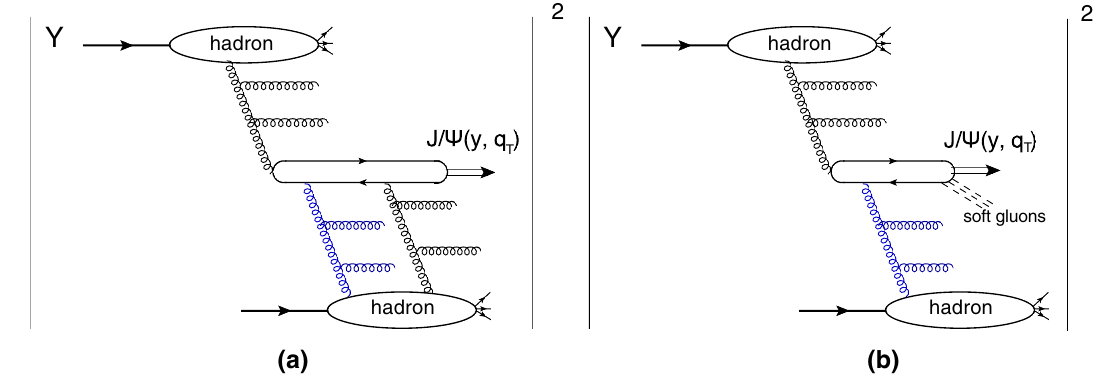
Fig. 1 Quarkonia production via three-pomeron fusion ( a ), and the two-pomeron fusion with additional soft gluon emission ( b )